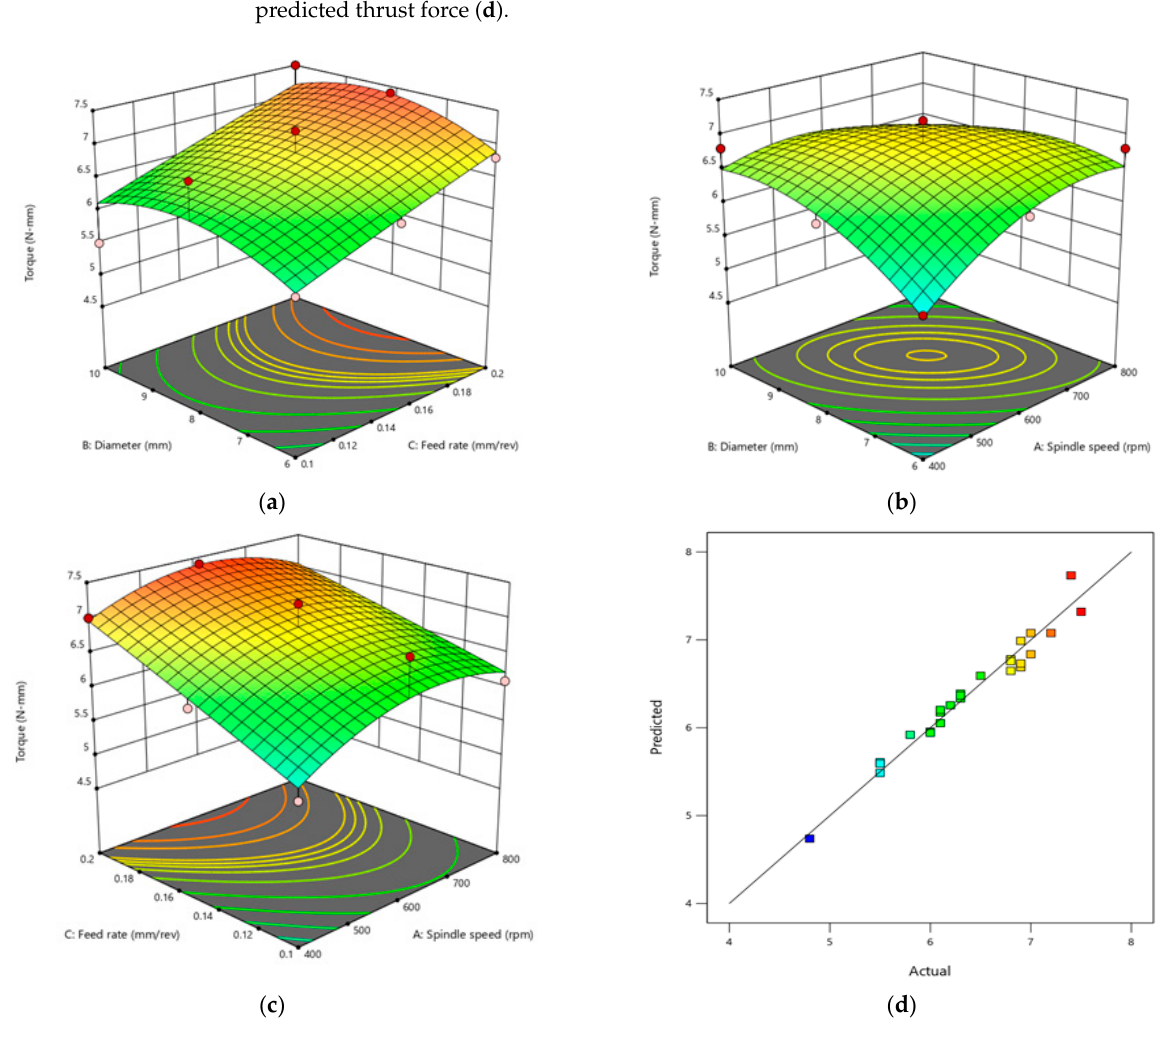
Figure 10. The 3D surface plot of the variables controlling torque. ( a ) Interactions between the diameter and the feed rate, ( b ) diameter and the spindle speed, ( c ) spindle speed and feed rate. ( d ) Estimated vs. actual torque.